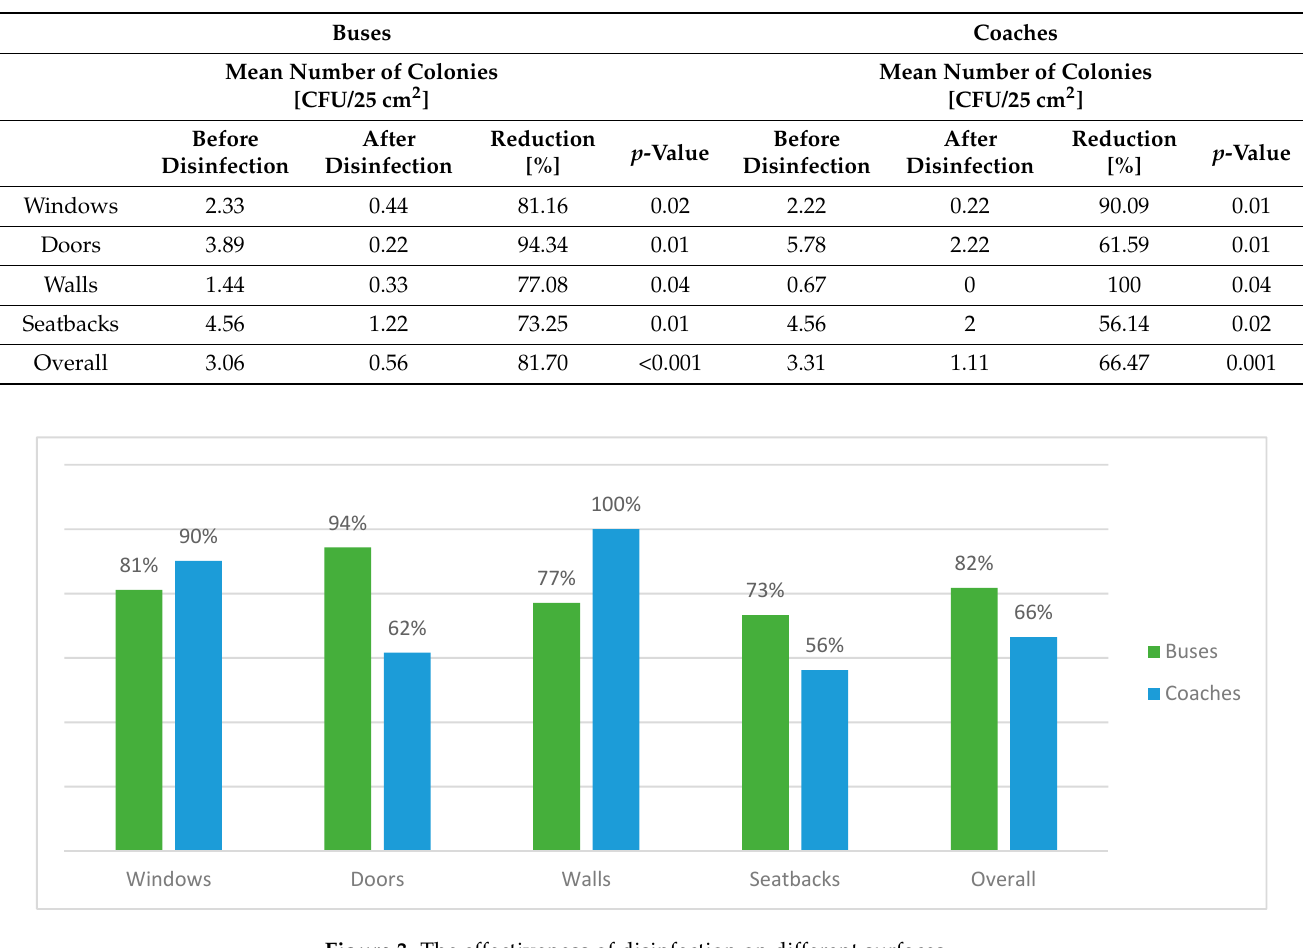
Figure 3. The effectiveness of disinfection on different surfaces.